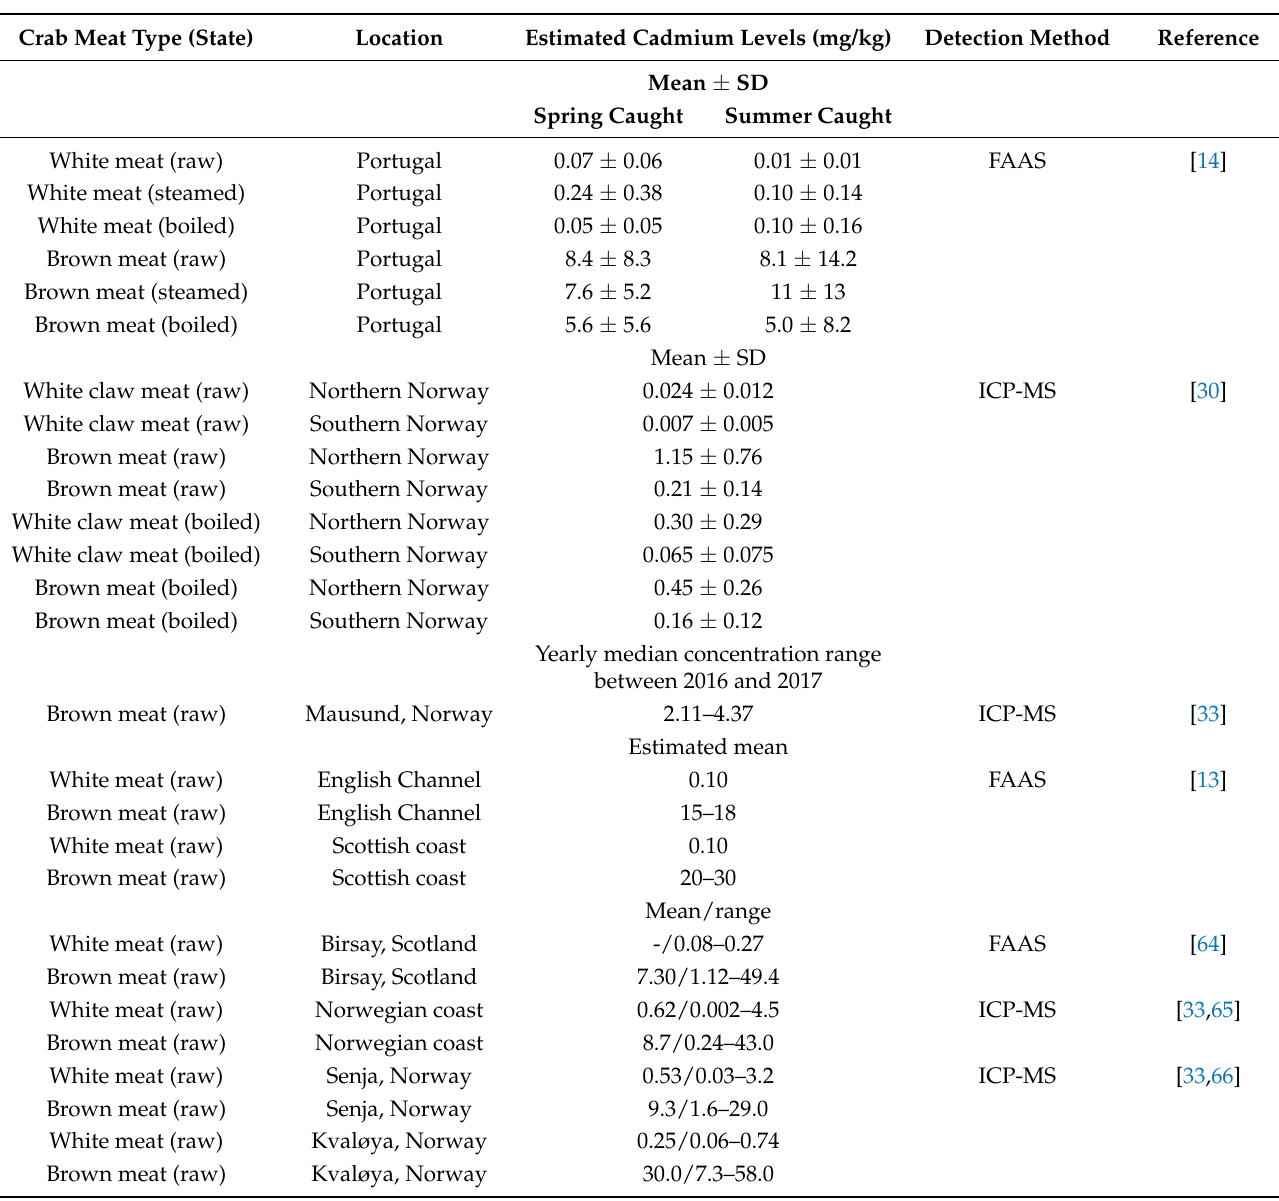
Table 1. An overview of cadmium concentrations in brown crab ( Cancer pagurus ) expressed as mg/kg